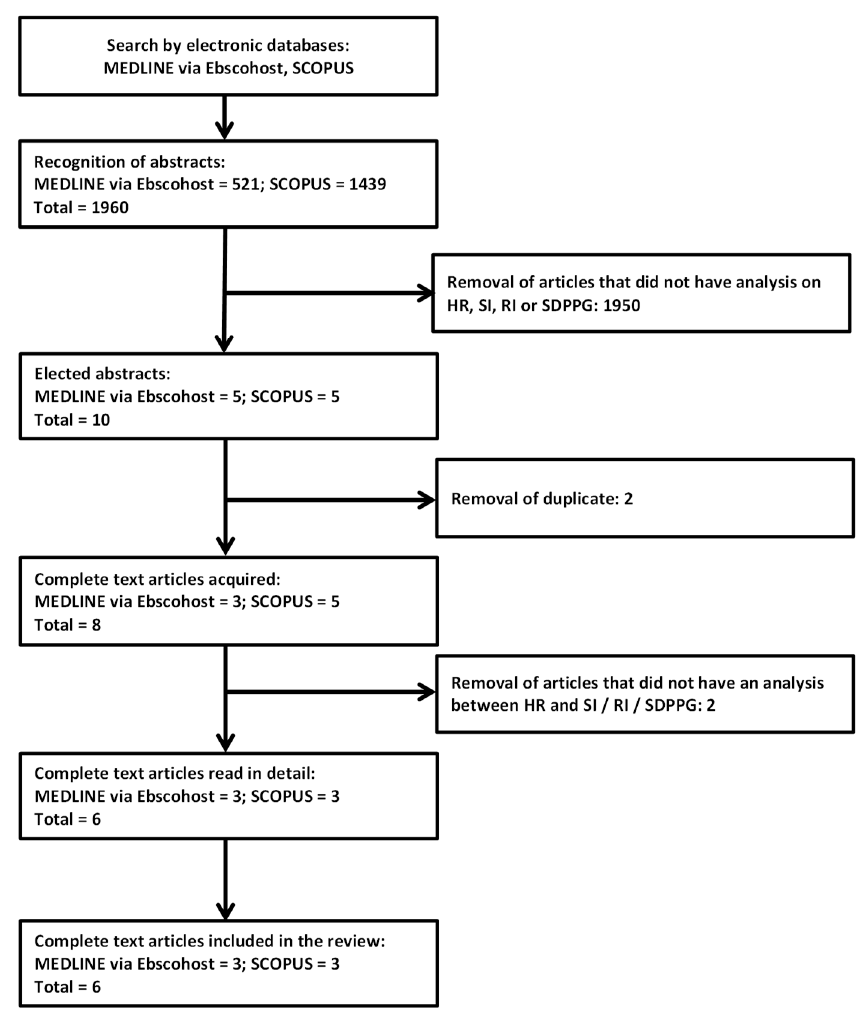
Figure 4. Flowchart of the election of the related articles.